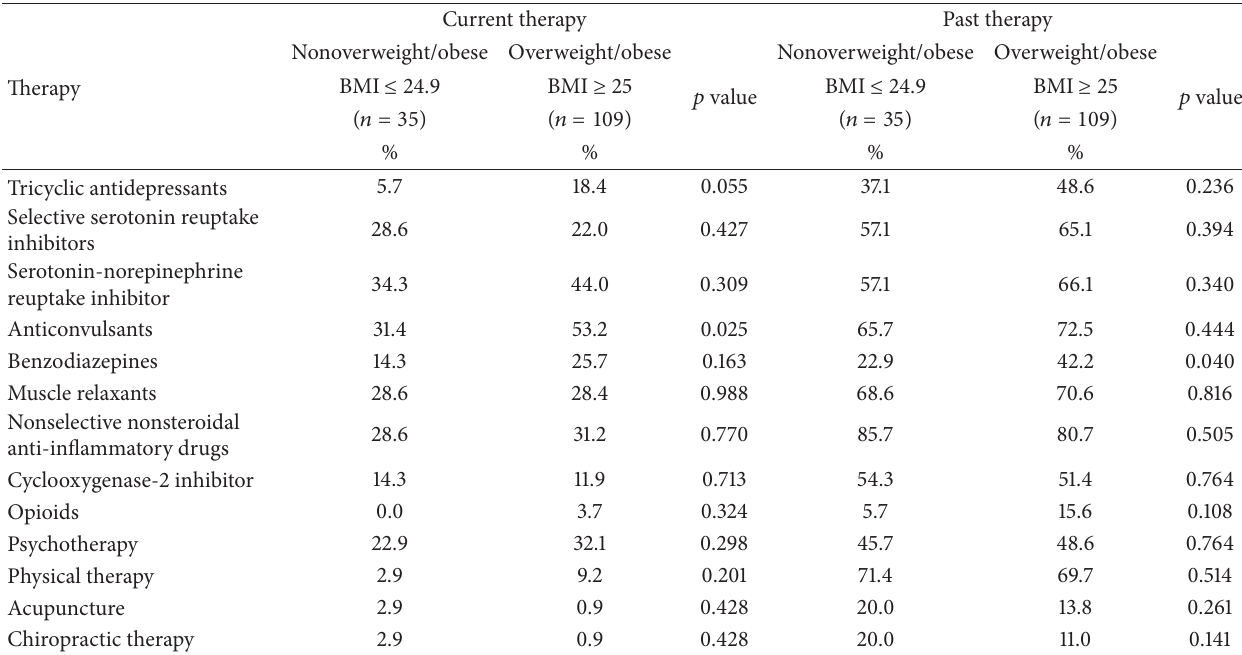
Table 4: Current and past pharmacological and nonpharmacological therapies in nonoverweight/obese and overweight/obese fibromyalgia